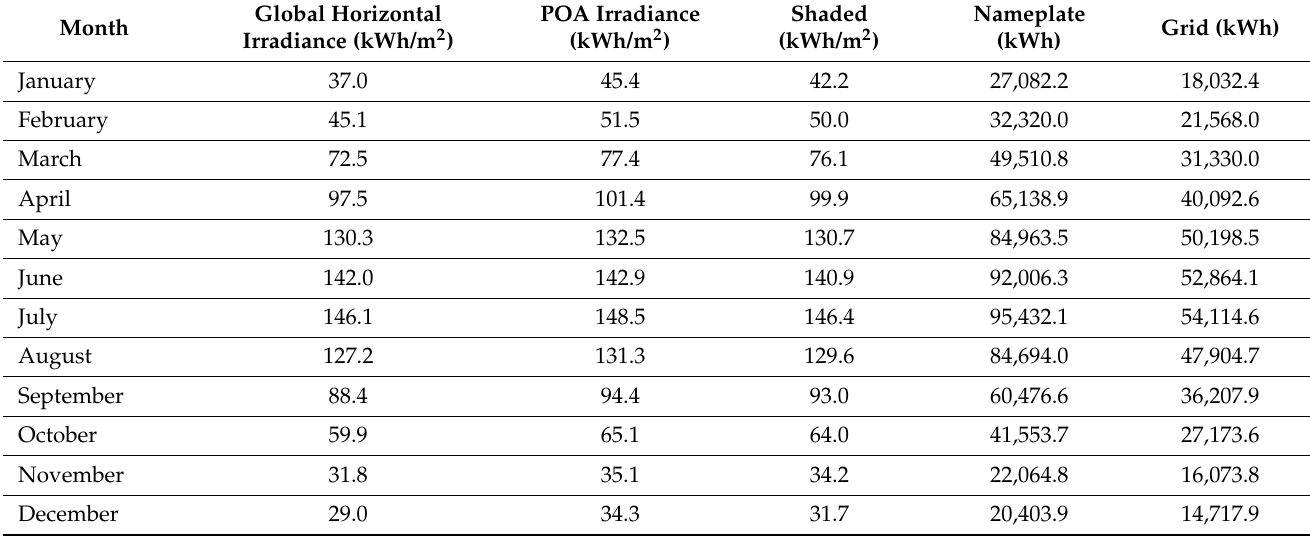
Table 5. Energy production from the PV installations of 691.3